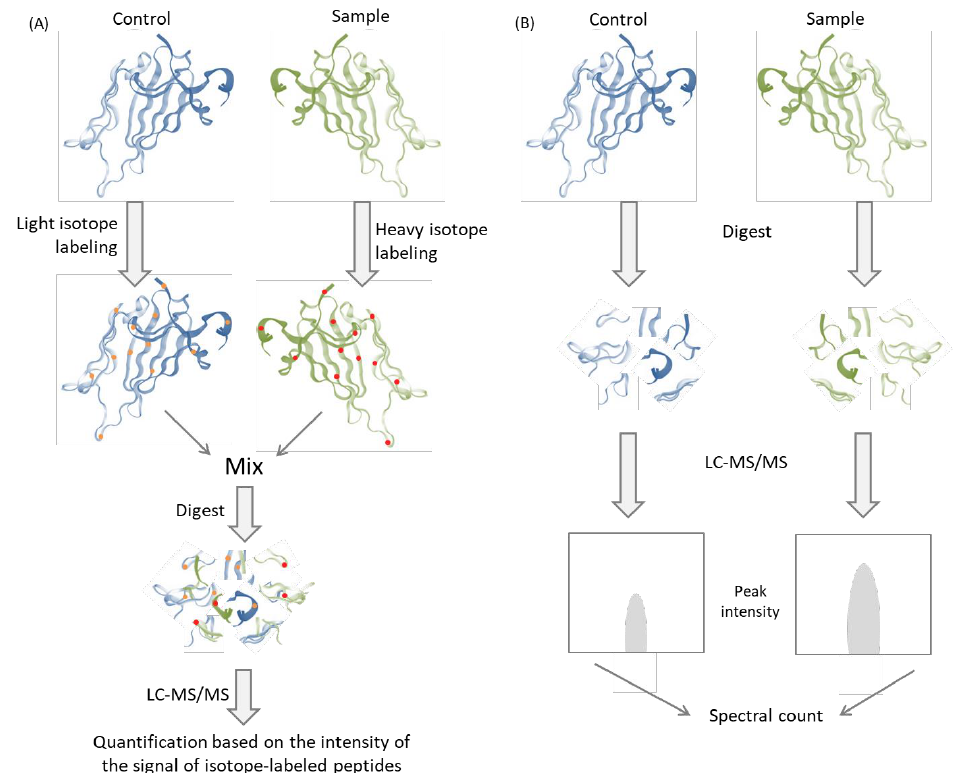
Figure 4. Schematic presentation of two approaches of quantitative proteomics. ( A ) Shotgun isotope labelling method. Samples are labelled with light or heavy isotope, combined and analysed by LC-MS/MS method. Based on the intensity ratio of isotope-labelled pairs of peptides, quantification is performed. ( B ) Label-free quantitative proteomics. Samples are digested and analysed in individual LC-MS/MS experiments. Based on the comparison of peak intensity of the same peptides, quantification is performed [103].